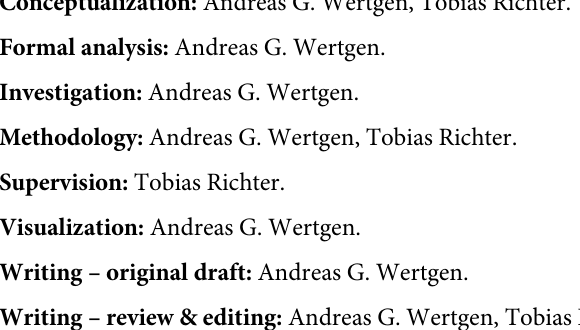
S2 Fig. Histogram of the mean probability of recall for all questions assessed with labora- tory surveys. S3 Fig. Histogram of the mean confidence judgments for all questions assessed with online surveys. S4 Fig. Histogram of the mean confidence judgments for all questions assessed with labo- ratory surveys. S5 Fig. Histogram of the mean peer judgments for all questions assessed with online sur- veys. S6 Fig. Histogram of the mean peer judgments for all questions assessed with laboratory surveys. S1 Table. Probabilities of recall (with confidence intervals), mean response latencies, pro- portions of errors (with confidence intervals), confidence judgments (with confidence intervals), peer judgements (with confidence intervals), and correlations between the judgements and the probability of recall for 356 general world knowledge questions. S2 Table. Overview of the most frequent commission errors for questions with a propor- tion of commission errors of .05 or greater of the total